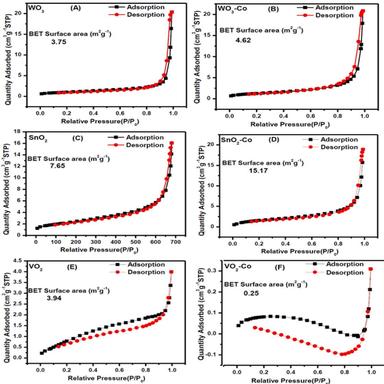
N2 adsorption-desorption isotherms of WO3, WO3-Co, SnO2, SnO2-Co, VO2, VO2-Co (a, b, c, d, e, and f) respectively and their surface area. (For interpretation of the references to colour in this figure legend, the reader is referred to the web version of this article.)